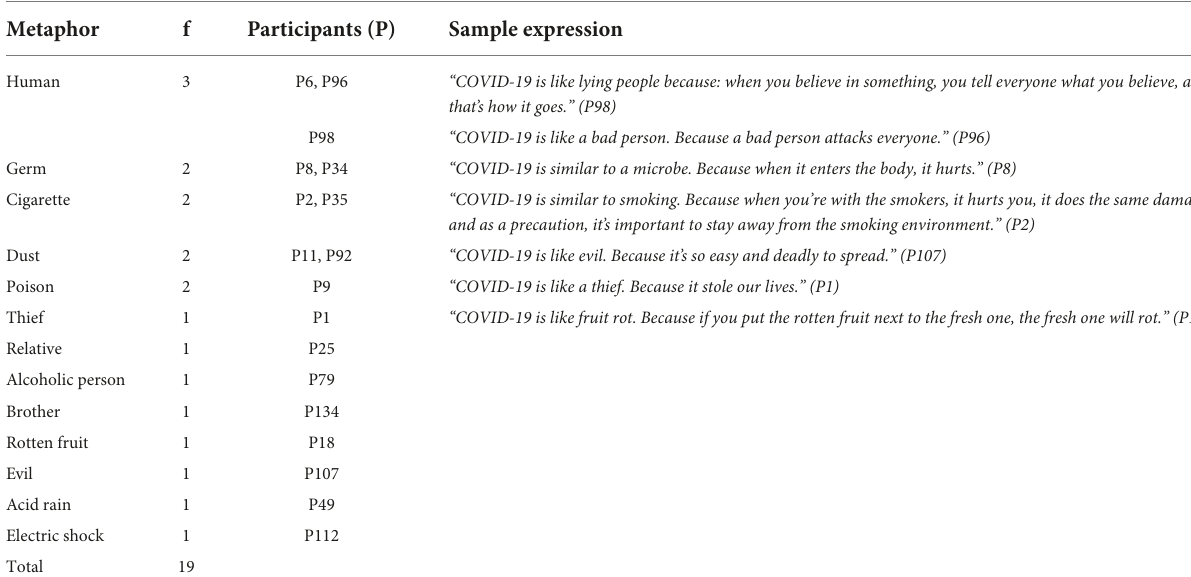
TABLE 6 Damaging